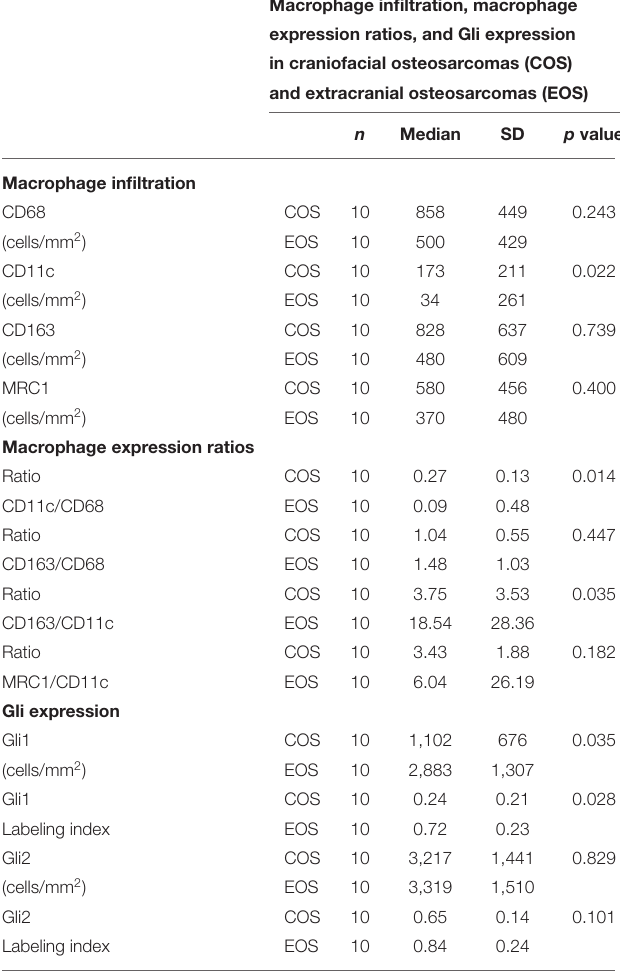
TABLE 2 | Macrophage cell count (positive cells/mm 2 ) and the macrophage marker expression ratio in craniofacial (COS) and extracranial osteosarcomas